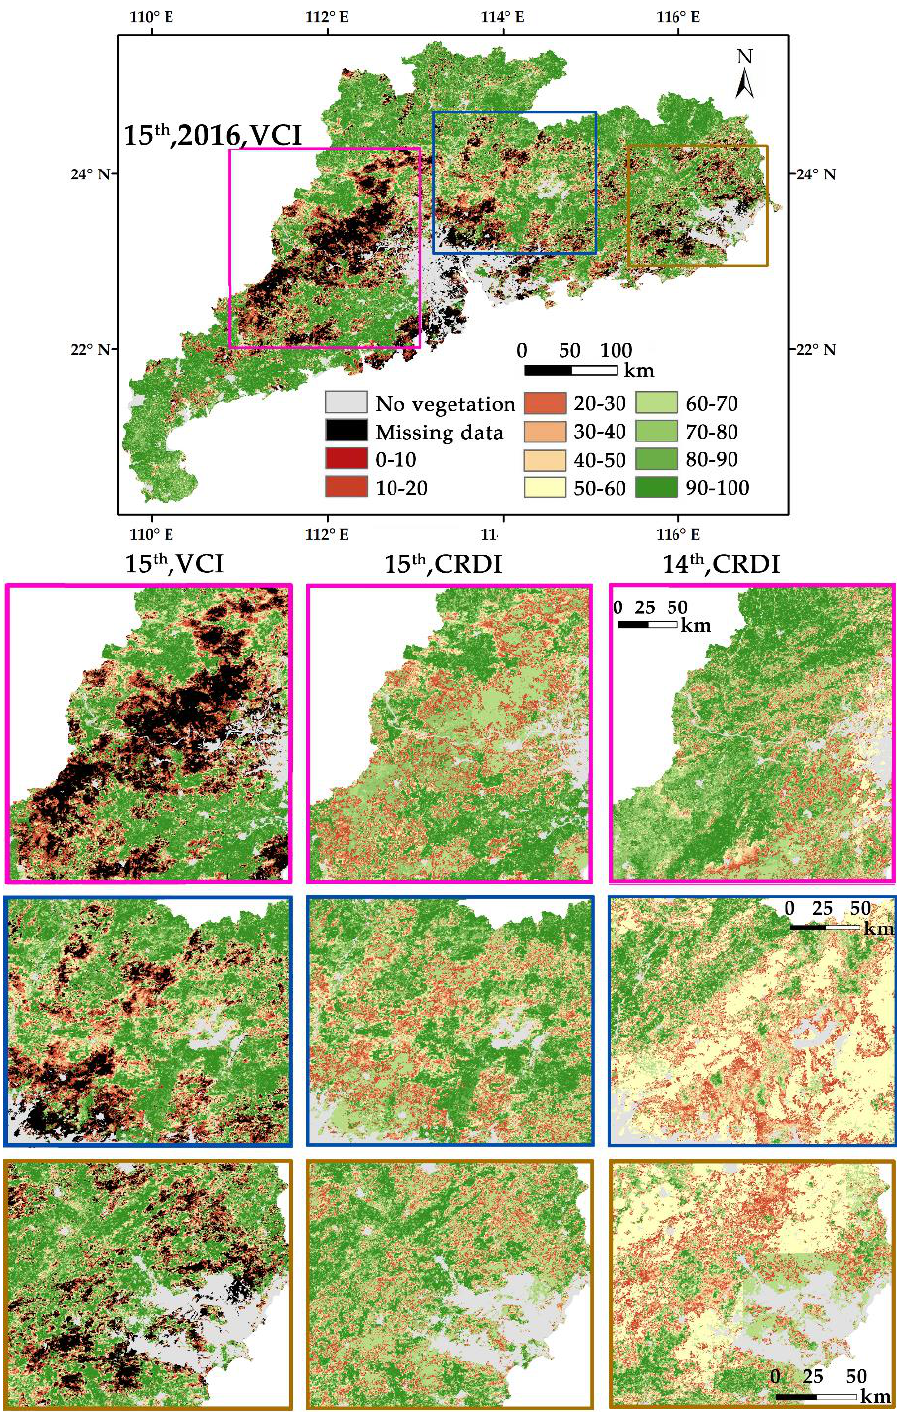
Figure 12. Comparison of spatial distribution of original VCI, current CRDI and previous CRDI of the 15th period of 2016.